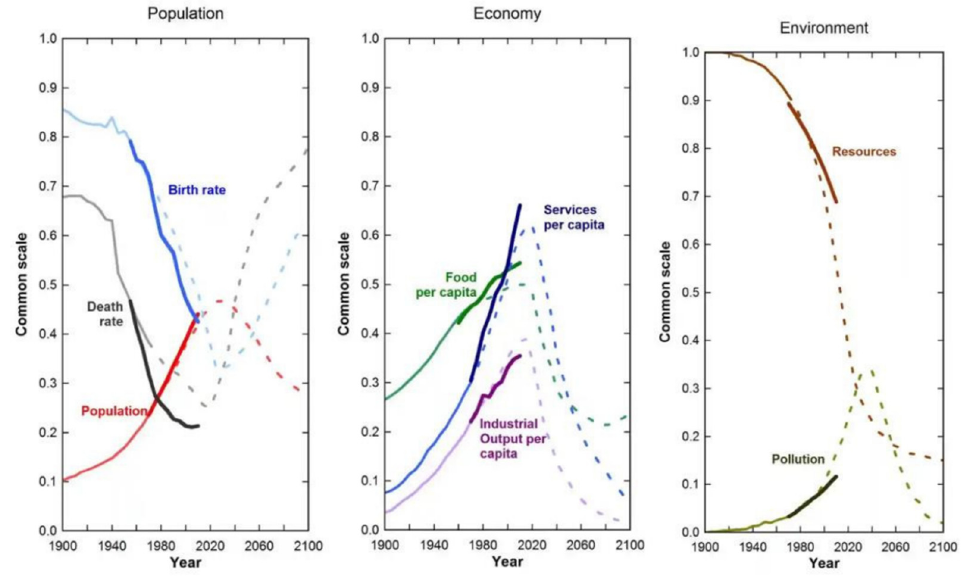
Figure 2. Comparison of the limits to growth standard run with subsequent empirical data [13].